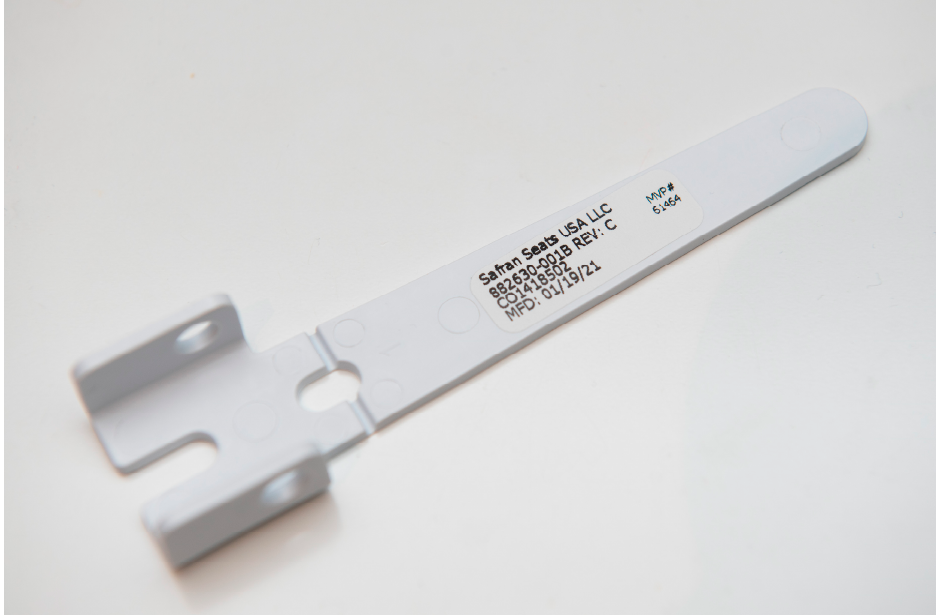
Figure 1. The studied aircraft part, namely, a finger pinch shroud from a Safran Seats US Z300 passenger seat.